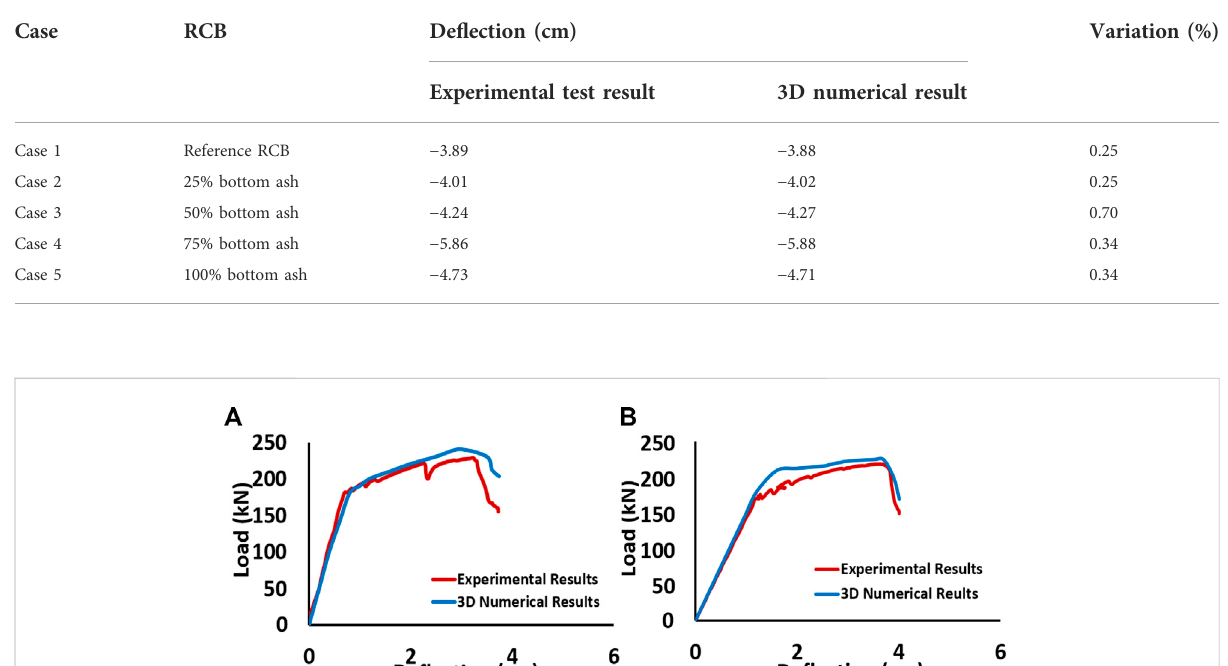
TABLE 6 De fl ection data under vertical force, which were obtained by experiments and computer